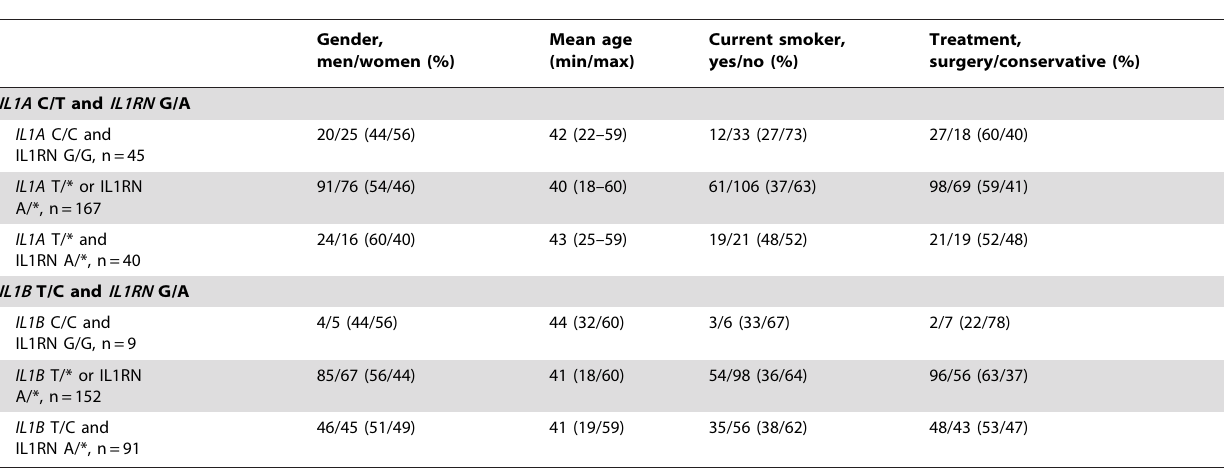
Table 2. Characteristics of patients grouped by the IL1A / IL1B and IL1RN